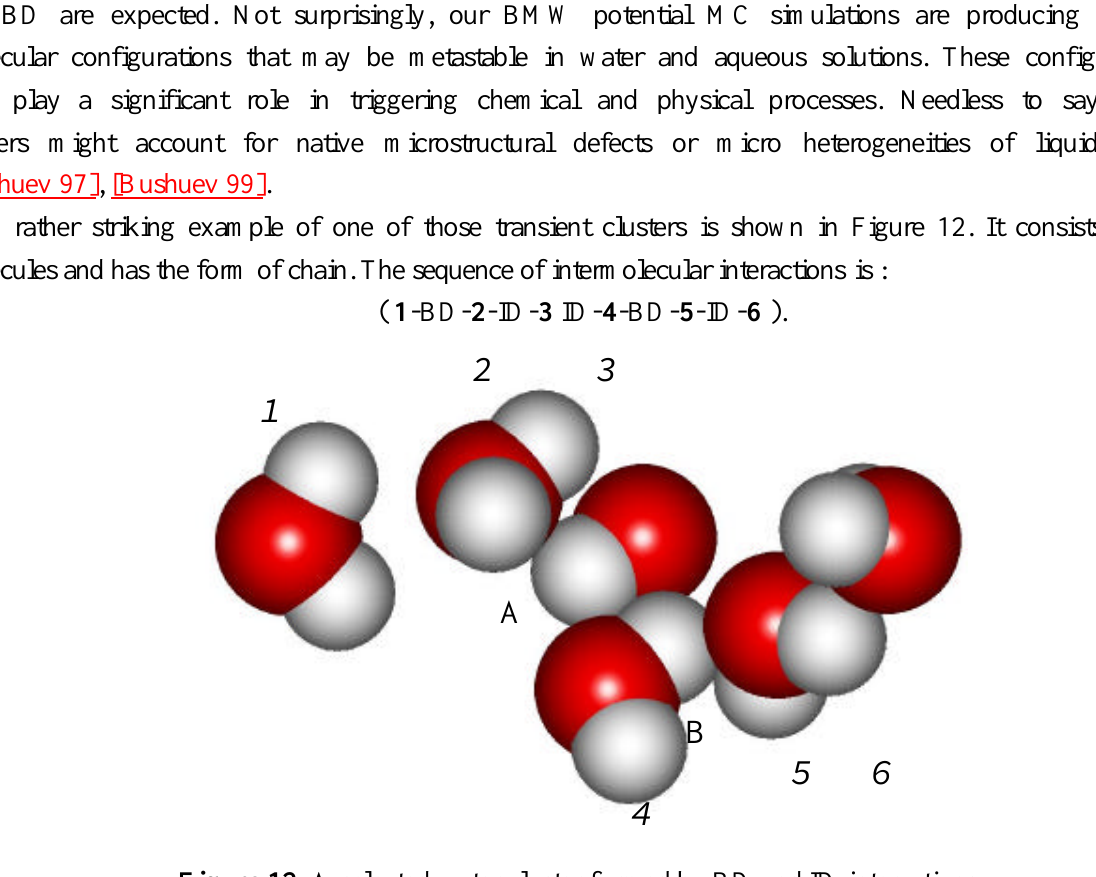
Figure 12. A selected water cluster formed by BD and ID